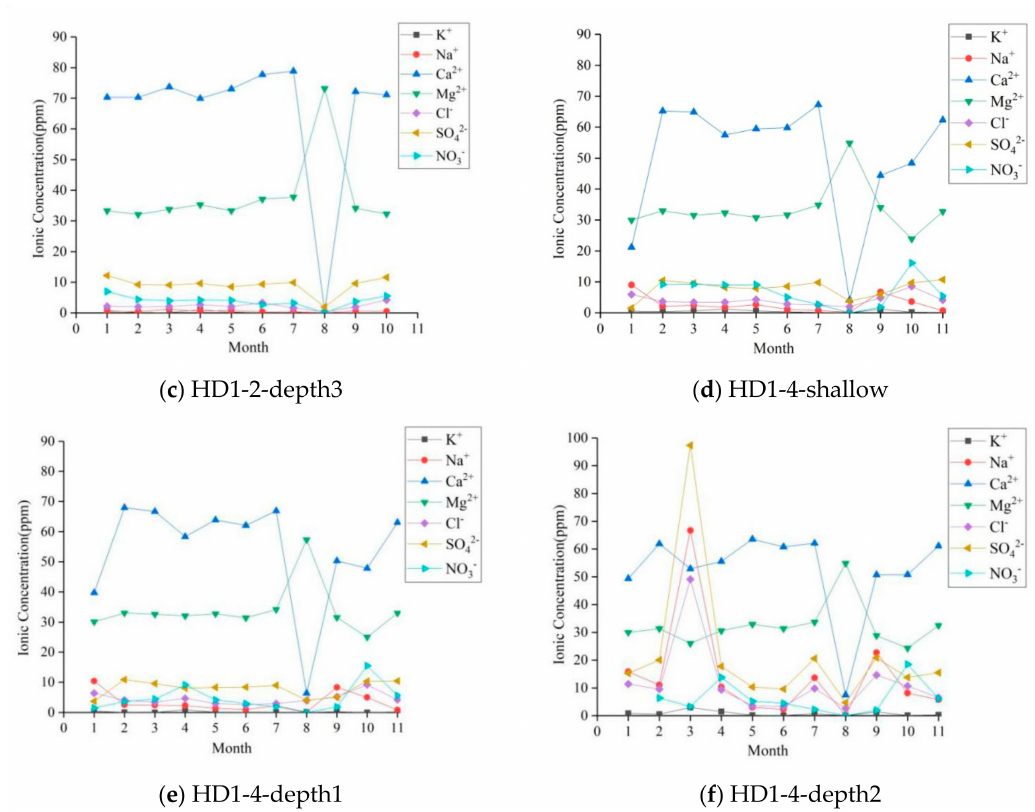
Figure 7. Trend chart of main anion and cation concentration changes over time.